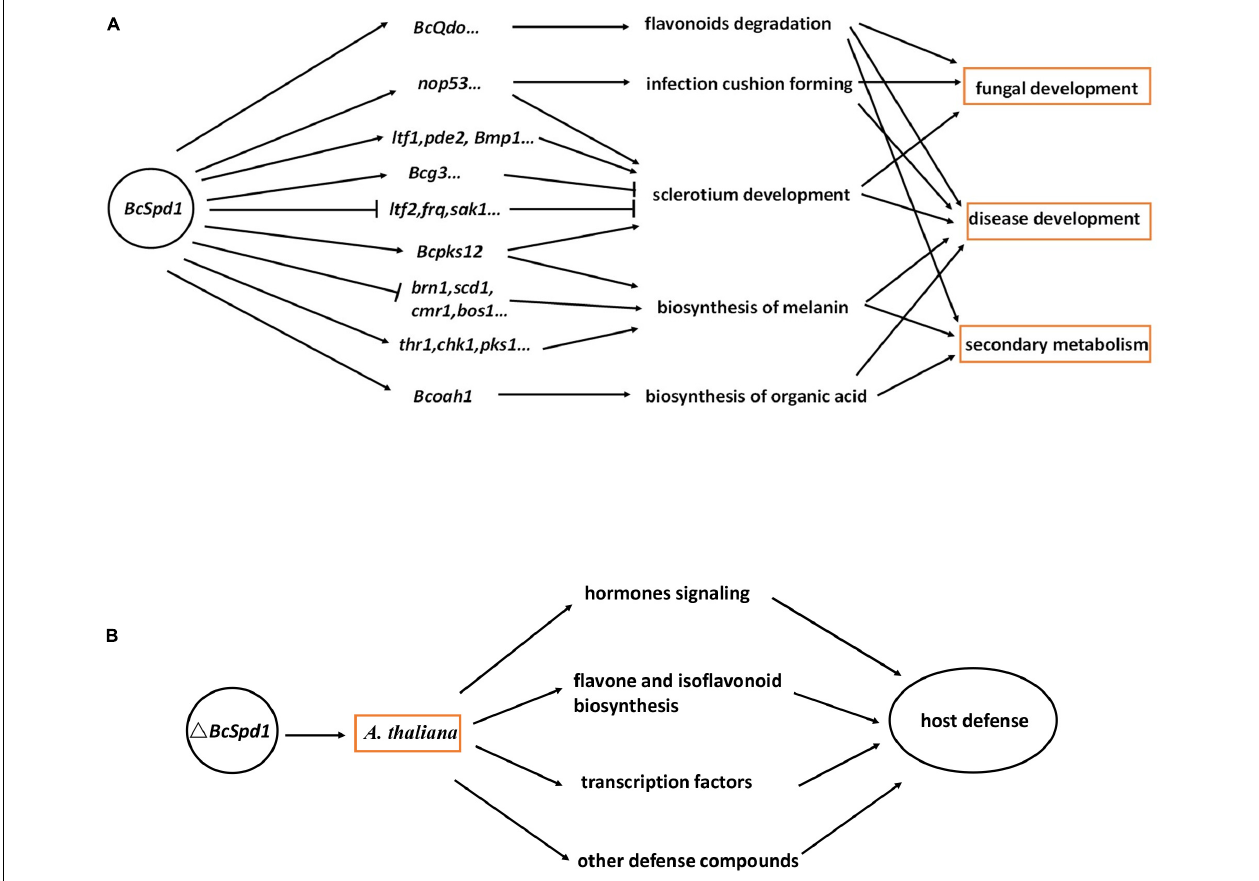
FIGURE 8 | Models showing the role of BcSpd1 in plant– B. cinerea interaction. (A) B. cinerea BcSpd1 is involved in regulating genes in fungal growth, development, secondary metabolism, pathogenicity, and anti-microbe plant metabolism degradation. (B) (cid:49) BcSpd1 recovered from host defense by upregulating many genes in the hormone pathway, transcription factors, and defense-related secondary metabolism